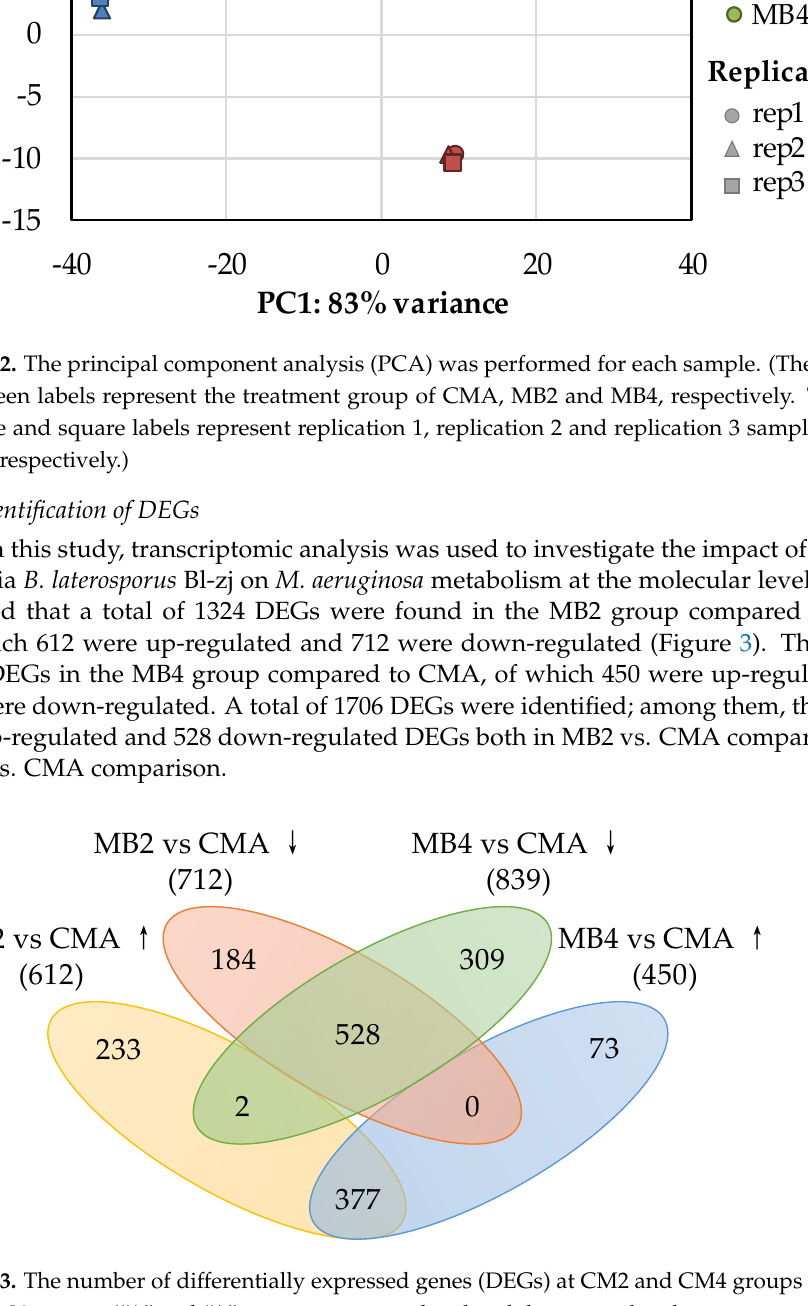
Figure 3. The number of differentially expressed genes (DEGs) at CM2 and CM4 groups compared with CMA group. (“ ↑ ” and “ ↓ ” represent up-regulated and down-regulated genes, respectively.)